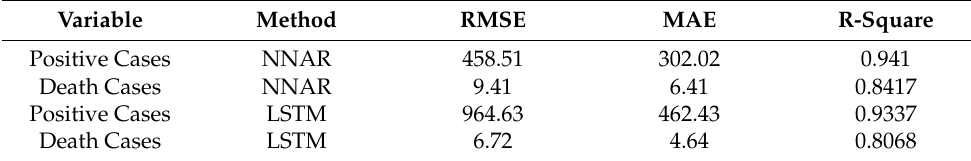
Table 3. Forecasting daily death cases caused by COVID-19 using LSTM.